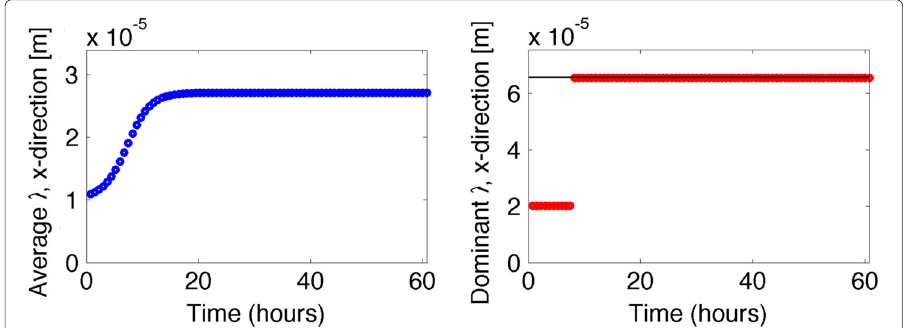
Fig. 3 Convergence of the averaged wavelength in the x-direction ( left ) to show changes in the distribution function over time. The dominant wavelength ( right ) shows the ripple wavelength that is most present in the morphology. Blackhorizontalline indicates analytical